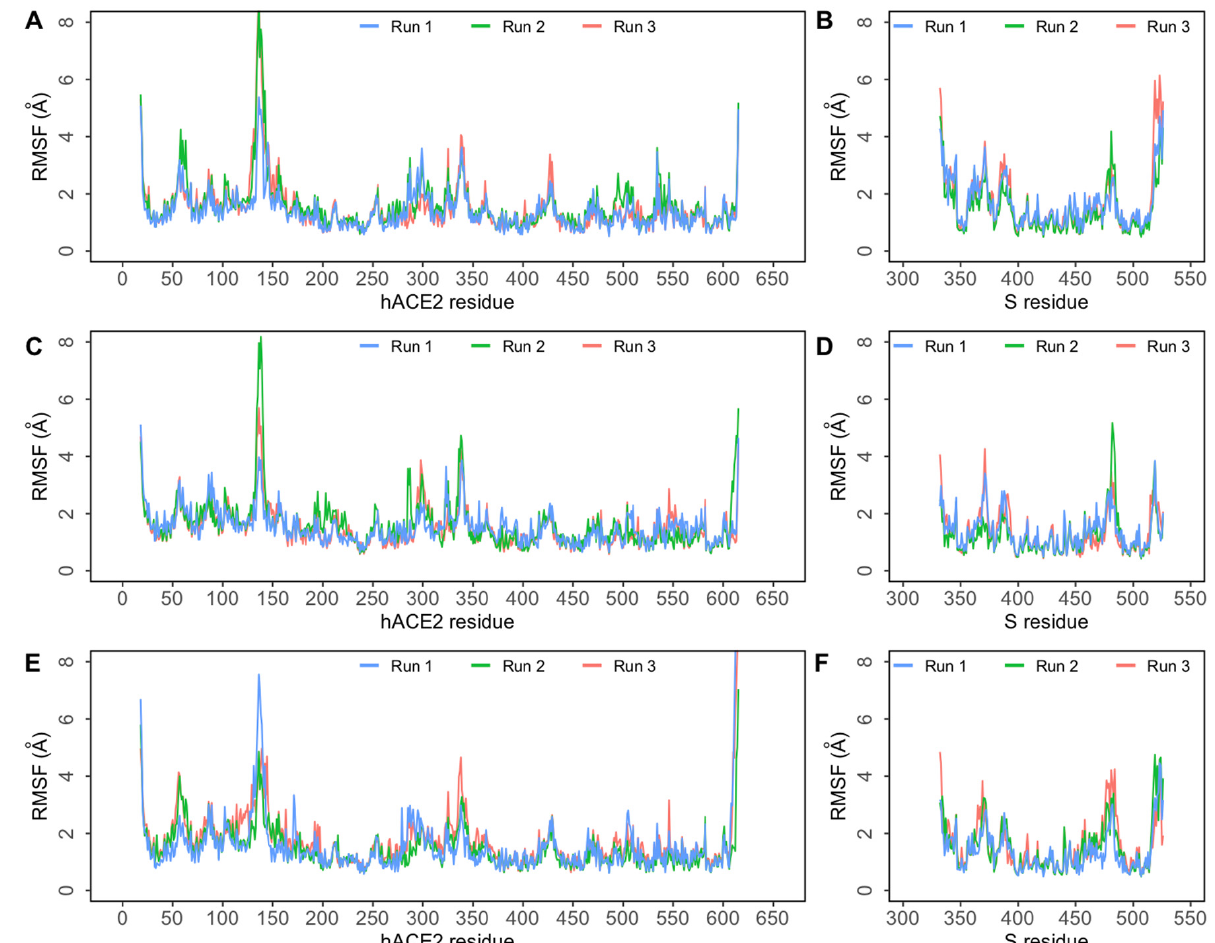
Figure 3. Root mean square fluctuation (RMSF) of protein C α atoms obtained from three independent 500 ns simulations of SARS-CoV-2 spike (S) protein bound to human ACE2 (hACE2). ( A ) RMSF of C α atoms of hACE2 protein in the E484Q + L452R complex; ( B ) RMSF of C α atoms of SARS-CoV-2 S RBD in the E484Q + L452R complex; ( C ) RMSF of C α atoms of hACE2 protein in the E484Q complex; ( D ) RMSF of C α atoms of SARS-CoV-2 S RBD in the E484Q complex; ( E ) RMSF of C α atoms of hACE2 protein in the L452R complex; ( F ) RMSF of C α atoms of SARS-CoV-2 S RBD in the L452R complex.